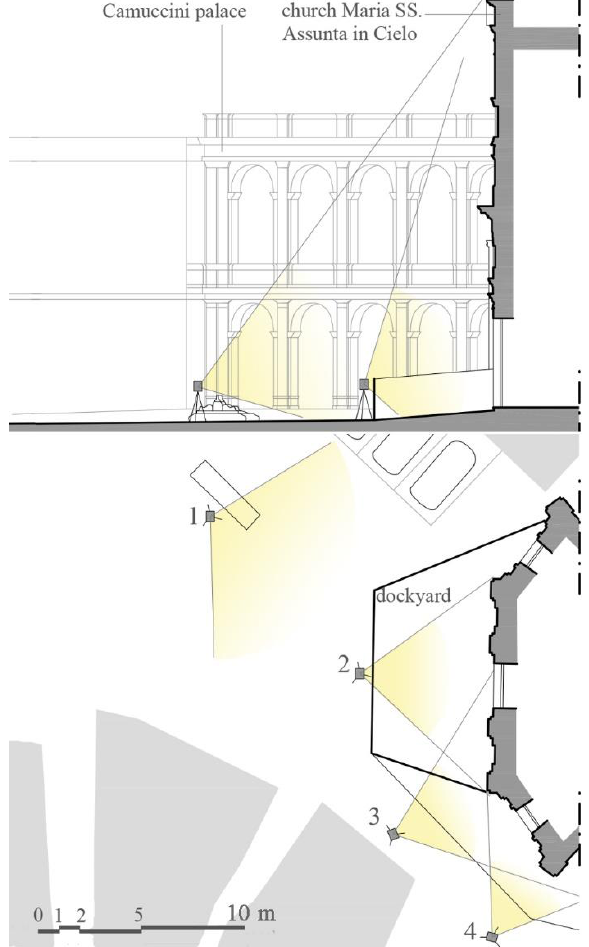
Figure 3. Position of the laser scanner in the square and in the street near the